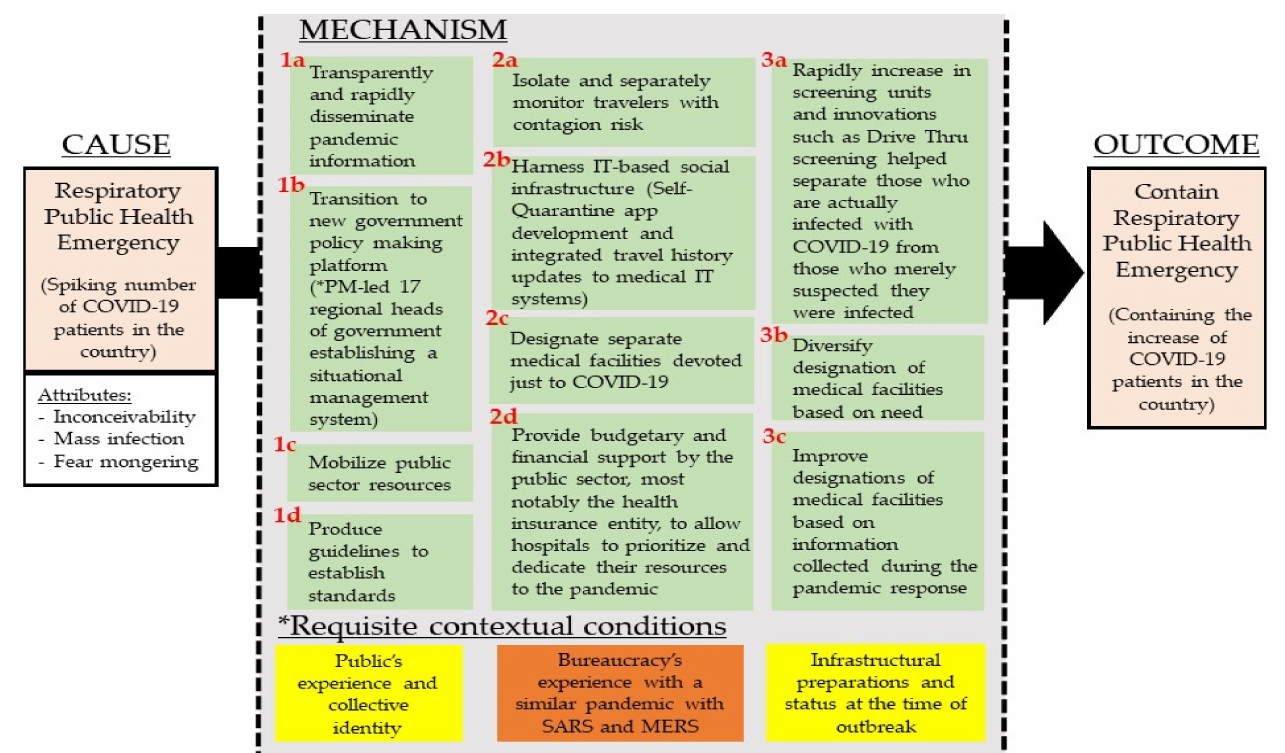
Figure 3. South Korea COVID-19 Response Causal Mechanism